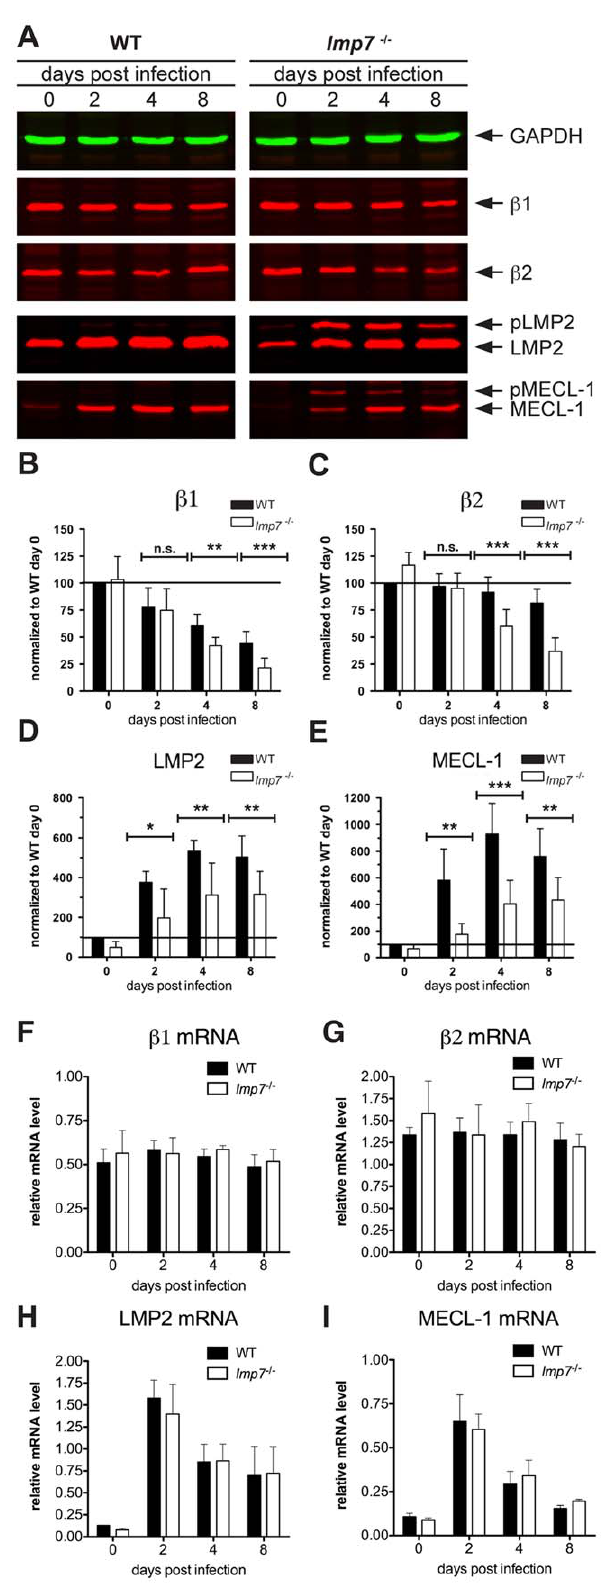
Figure 5. Quantification of b 1, b 2, LMP2 and MECL-1 expression at protein and mRNA level in WT and lmp7 2 / 2 mice during the course of listeria infection. Both groups of mice were infected i.v. with 5 6 10 3 cfu of L. monocytogenes and livers of three to four mice per